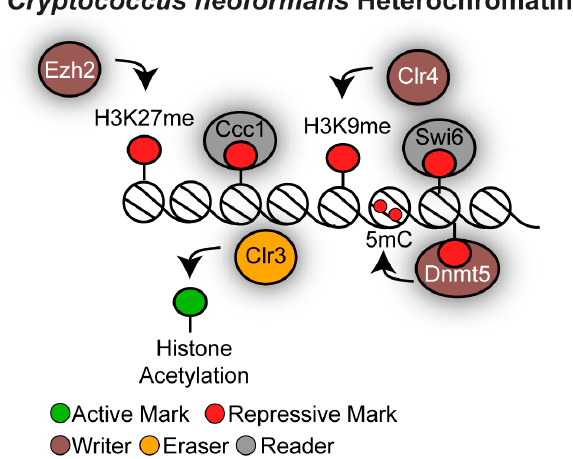
Figure 8. Heterochromatin structure in Cryptococcus neoformans. The methyltransferases Clr4 and Ezh3 methylate H3K9 and H3K27 respectively. 5mC DNA methylation that is dependent on the sole cytosine DNA methyltransferase Dnmt5. Swi6 and Dnm5 specifically recognise the H3K9me mark while Ccc1 binds the H3K27me mark. Histone hypoacetylation is ensured by the action of the histone deacetylase Clr3. Centromeres and subtelomeric regions are decorated by distinct histone modifications.